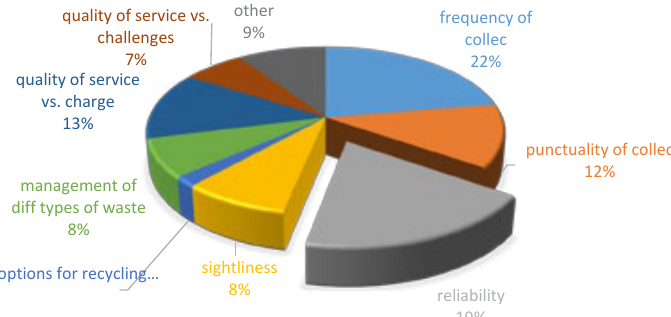
Fig. 5: Factors affecting residents rank of adequacy of garbage collection service